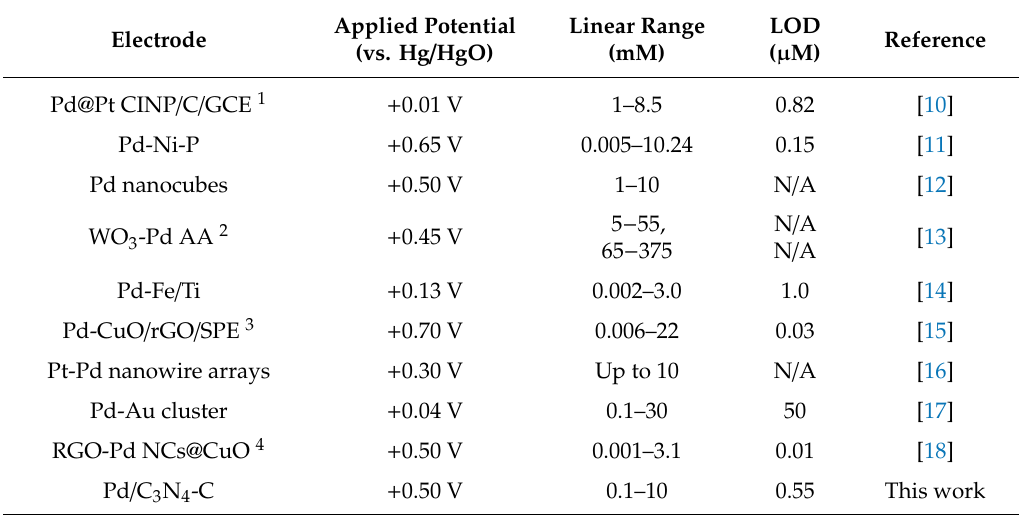
Table 1. Comparison of glucose oxidation on the Pd / C 3 N 4 -C electrode and other Pd electrodes. Applied Electrode